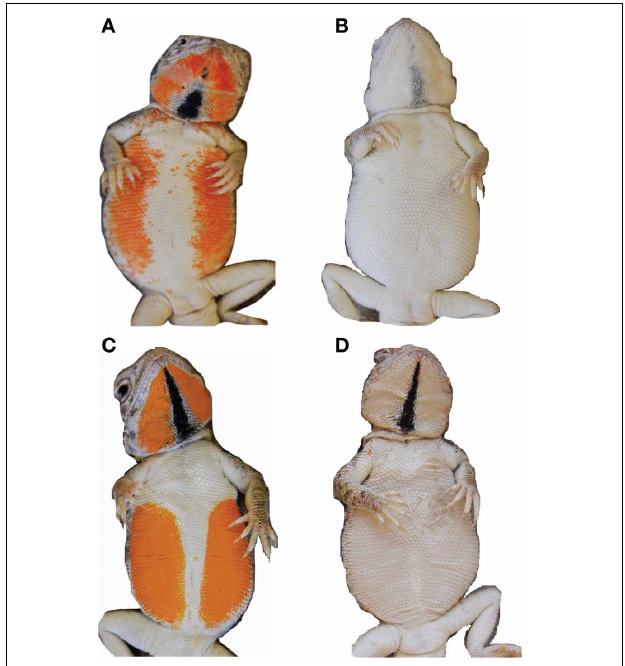
FIGURE 2 | Natural Ctenophorus maculosus female coloration and manipulated paint treatments. (A) naturally orange female (B) naturally white female (C) orange painted female (D) white painted female. FIGURE 3 | Natural female variation (A) small patch (B) pale and (C)